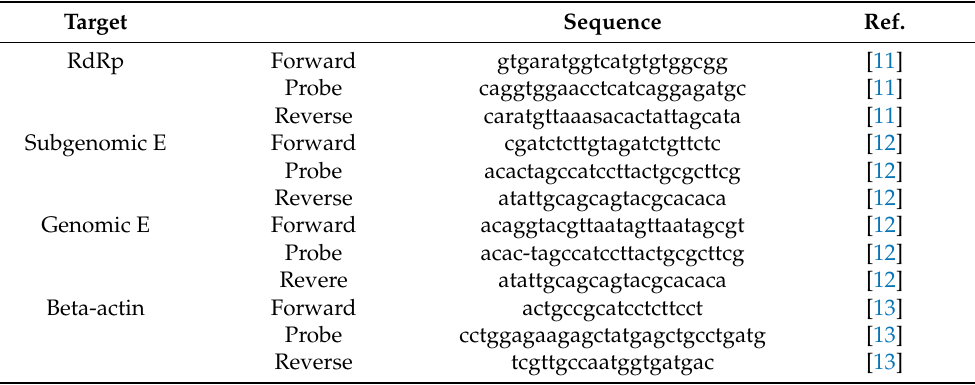
Table 1. Primer and probe sequences used in the